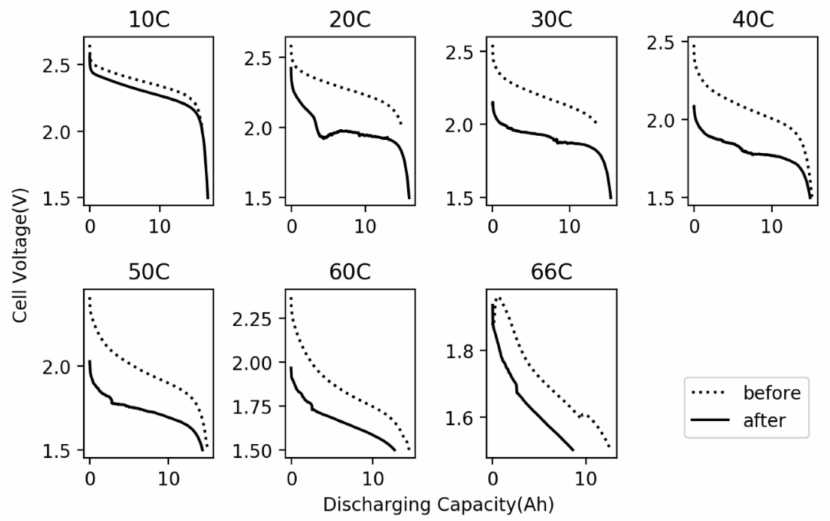
Figure 3. The discharging curves at different current rates before and after cycles of cell